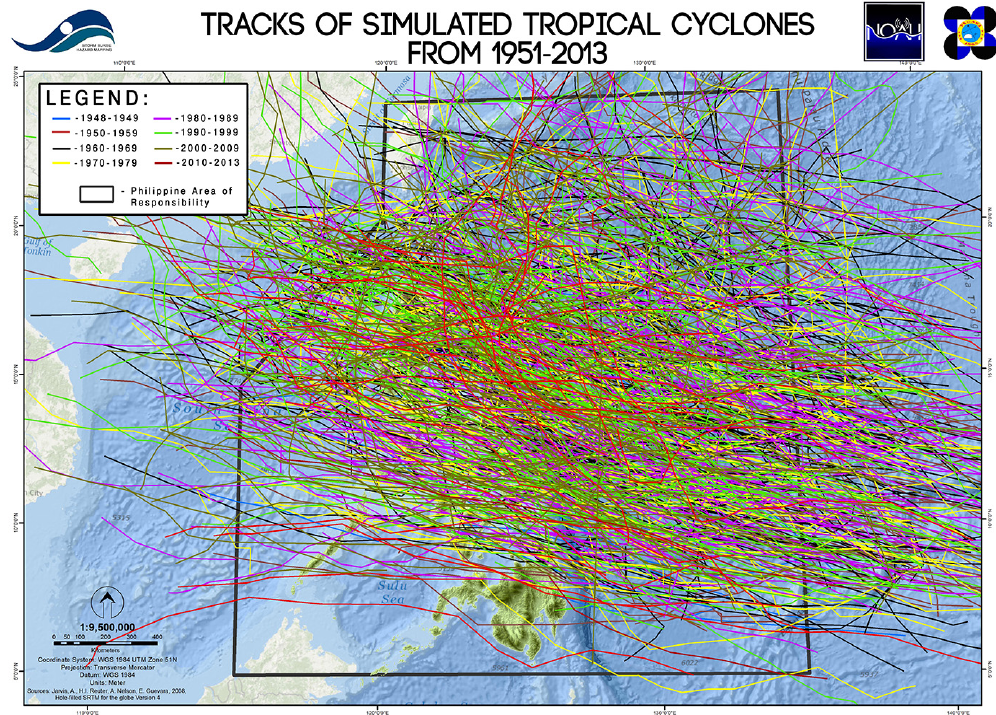
Figure 2. Tracks of tropical cyclones that entered the Philippine Area of Responsibility from 1951 to 2013 (Project